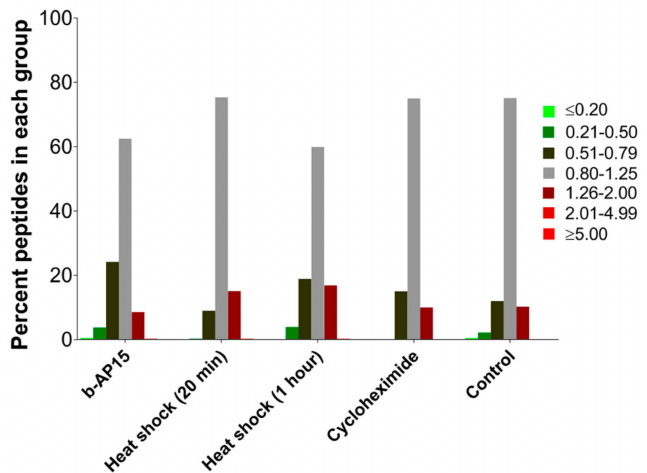
Figure 2. Percentage of peptides present in groups divided according to relative level. For samples subjected to b-AP15 (1 µ M, 1 h), heat shock (42 ◦ C for 20 min and 1 h), and cycloheximide (0.2 mM, 35 min) treatment, the ratios for both replicates were averaged for the analysis and the peptides were subsequently grouped based on the average relative levels. For peptides found multiple times with di ff erent charge states and / or numbers of tags, the peak intensities were summed and expressed as the ratio of average control such that a single value for peptide ratio could be obtained for each replicate, which were then averaged. For the controls, peptide ratios of each replicate of every peptide from all the experiments were combined together for the analysis. Data for each of the peptides are provided in Table